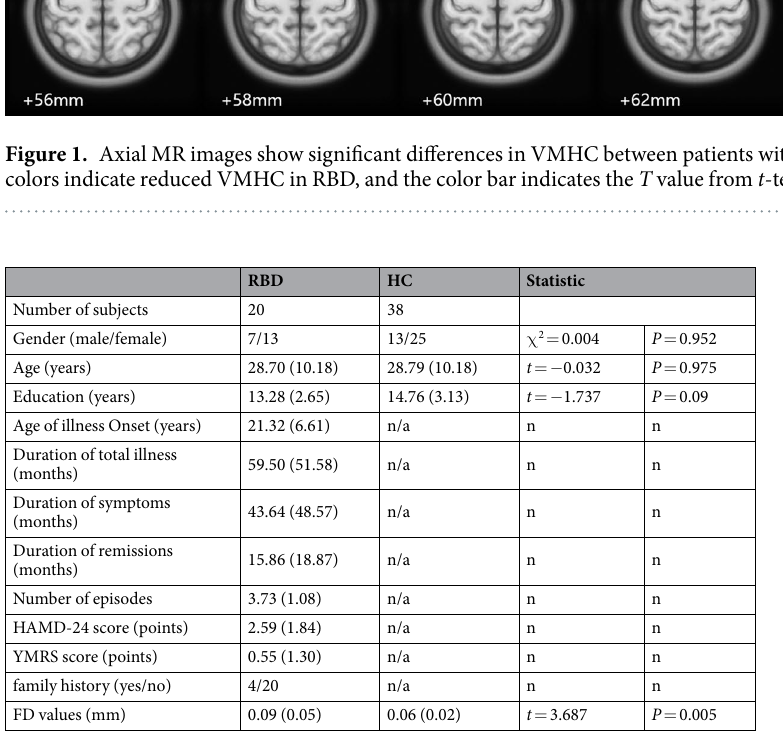
Table 1. The demographic characteristics of the subjects. Values are reported as mean (standard deviation), except for gender and family history. RBD = remitted bipolar disorder. HC = healthy controls. HAMD- 24 = Hamilton Rating Scale for Depression-24. YMRS = Young Mania Rating Scale. FD = framewise displacement for in scanner head motion.